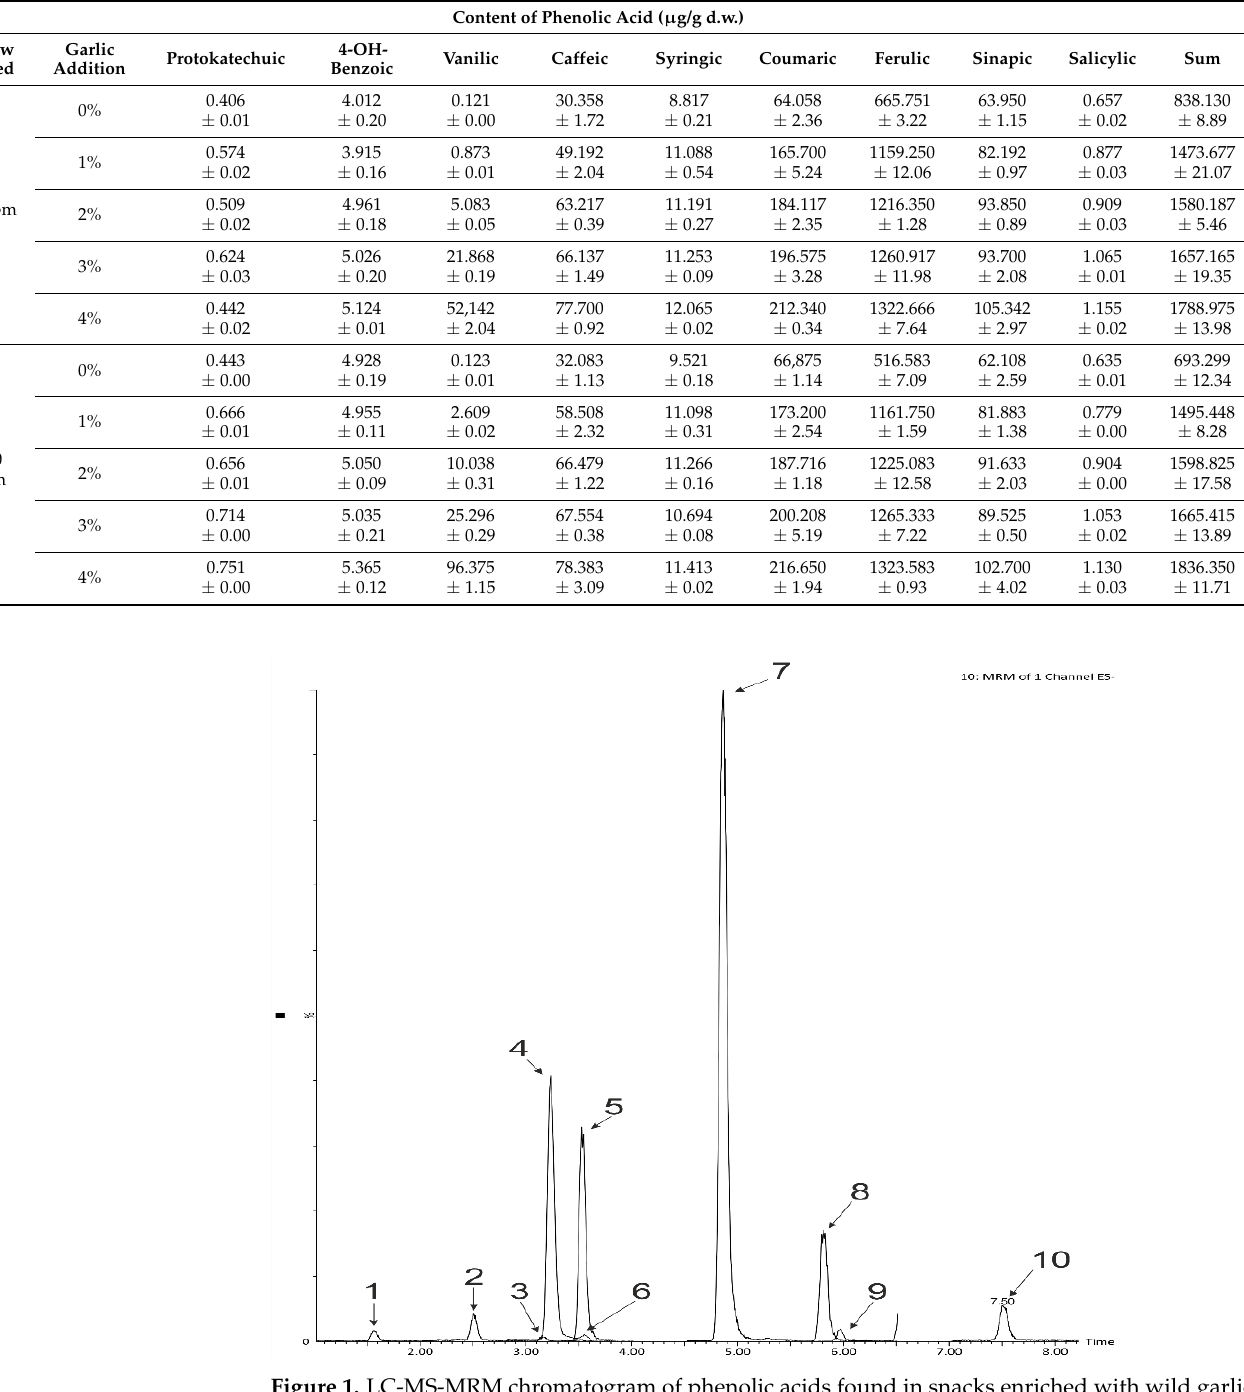
Figure 1. LC-MS-MRM chromatogram of phenolic acids found in snacks enriched with wild garlic (120 rpm, 3% of wild garlic, sample after hydrolysis): 1—protocatechuic, 2—4-OH-benzoic,